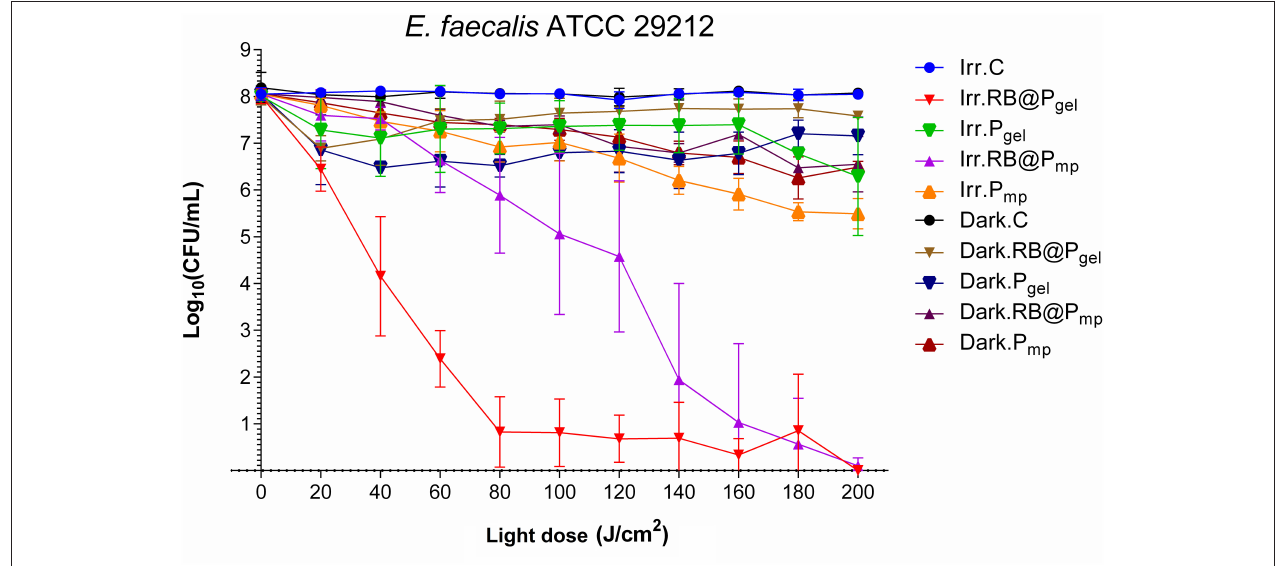
FIGURE 1 | Survival curves corresponding to the photodynamic inactivation of Enterococcus faecalis . Every point is the average of three independent experiments. Error bars correspond to the standard deviations. Legend titles: Irr , irradiated samples; Dark , controls in the darkness; C , control, only microbial suspension; RB@P gel ,